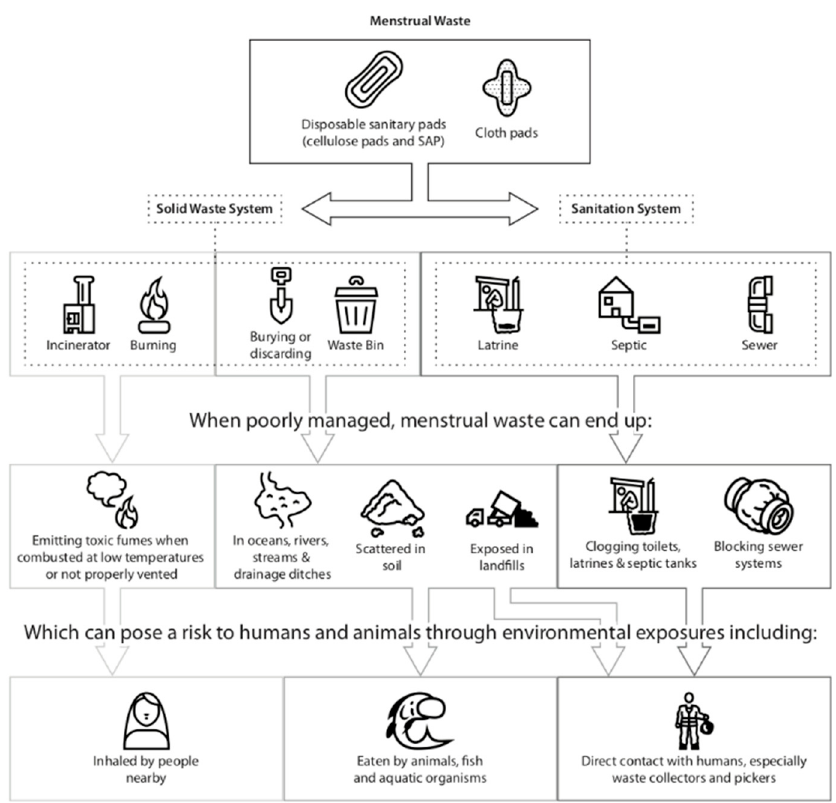
Figure 4. Waste disposal pathways and potential environmental and health hazards.